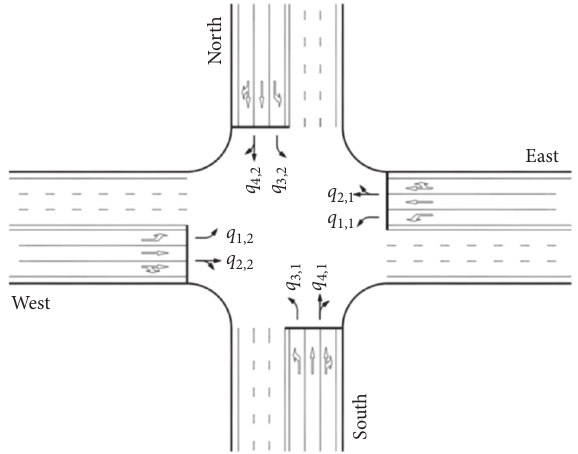
Figure 1: Example of an intersection